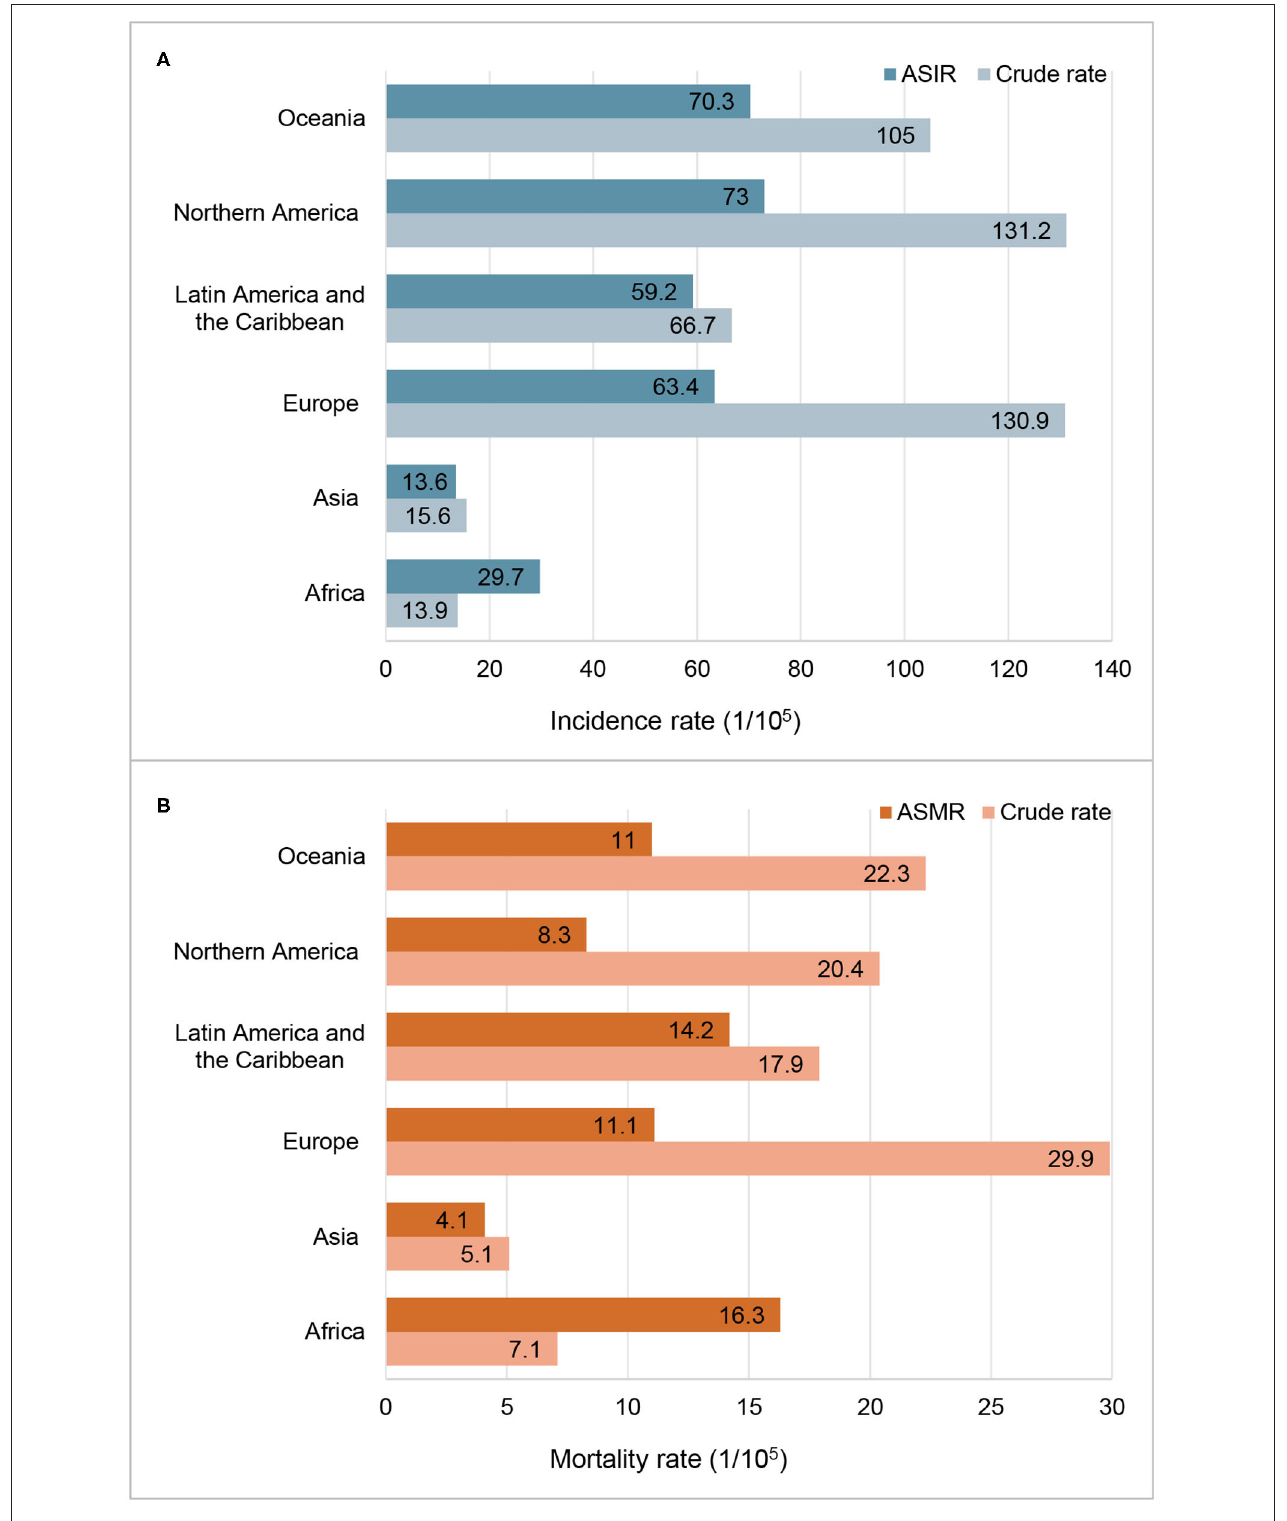
FIGURE 1 | Incidence and mortality of prostate cancer in 2020 by continent. (A) Incidence rate; (B) Mortality rate; ASIR, age-standardized incidence rate; ASMR, age-standardized mortality rate.